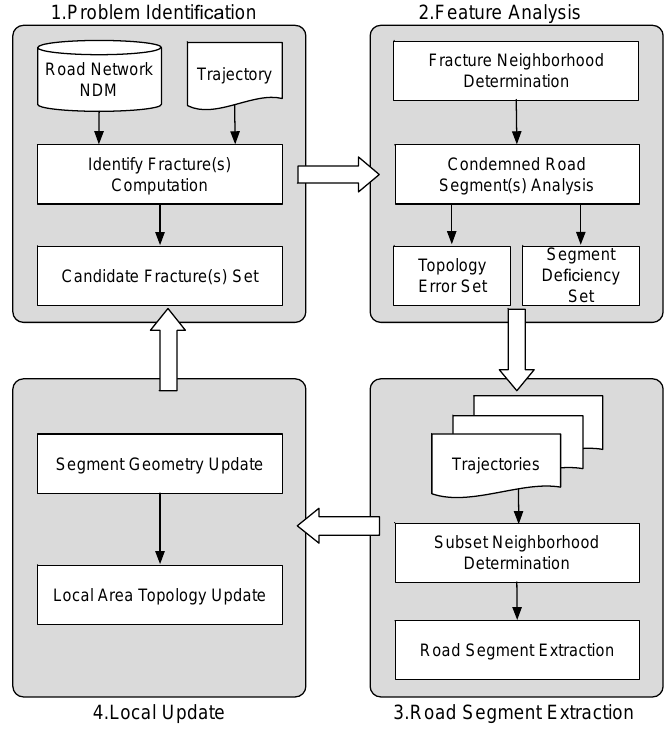
Figure 2. Overview of the updating strategy.